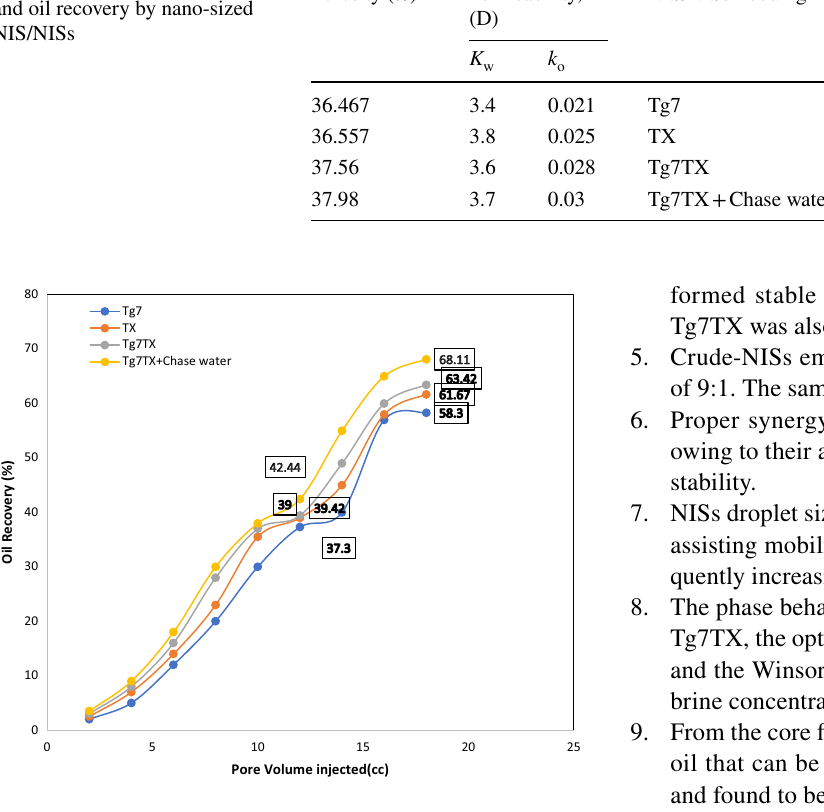
Table 9 Porous media property and oil recovery by nano-sized NIS/NISs